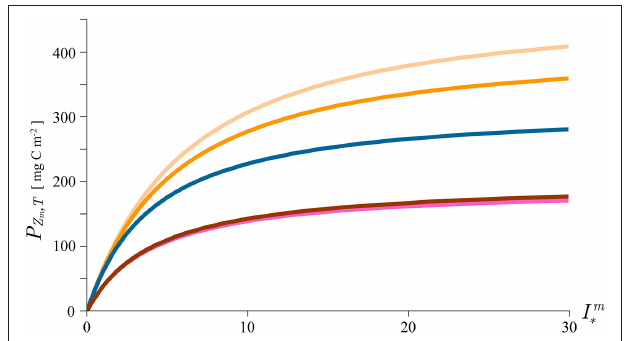
FIGURE 5 | Mixed layer production calculated with the canonical solution (8, blue curve), solution for growing biomass (29, two orange curves with different carbon-chlorophyll ratio), the solution with declining biomass (34, red curve) FIGURE 6 | Conceptual diagram highlighting the relations of the model and the approximation to the solution with declining biomass (36, pink curve). assumptions and analytical solutions with respect to growth (abscissa) and The parameters used in the solutions are typical of the Hawaii area and are mixing (ordinate). Growth is presented as change in biomass over time d B / d t , given by the median values of: Z m 54.75 m , P B m 7.85 whereas the effects of mixing are presented as d B / d z . Lines sketch the = = 0.072 mgChlm − 3 , and K 0.043 m − 1 . Daylength mgC(mgChl) − 1 h − 1 , B biomass profiles: orange for stratified biomass with week mixing and low = = D is set to 10 h , the dimensionless factor L B D to 1, carbon to chlorophyll ratio growth, blue for uniform biomass with intense mixing and low growth, and pink χ to 150 mgC(mgChl) − 1 (orange curve) and to 100 mgC(mgChl) − 1 (light for time dependent biomass with intense mixing. Solution for watercolumn orange curve). production with time dependent stratified biomass has yet to be found.